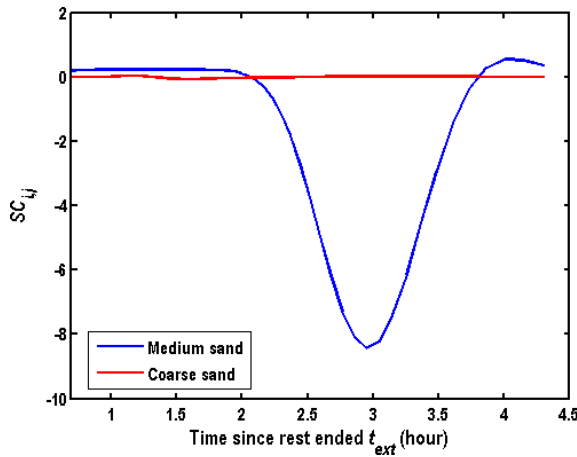
Figure 6. Sensitivity analysis of the hydraulic diffusivity on BTCs in the extraction